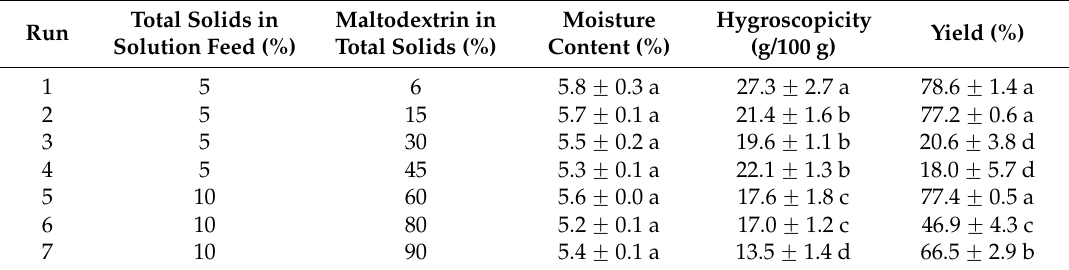
Table 1. Moisture content, hygroscopicity and yield of spray dried black bean extract powders obtained from feds with 5% or 10% total solids and different percentages of